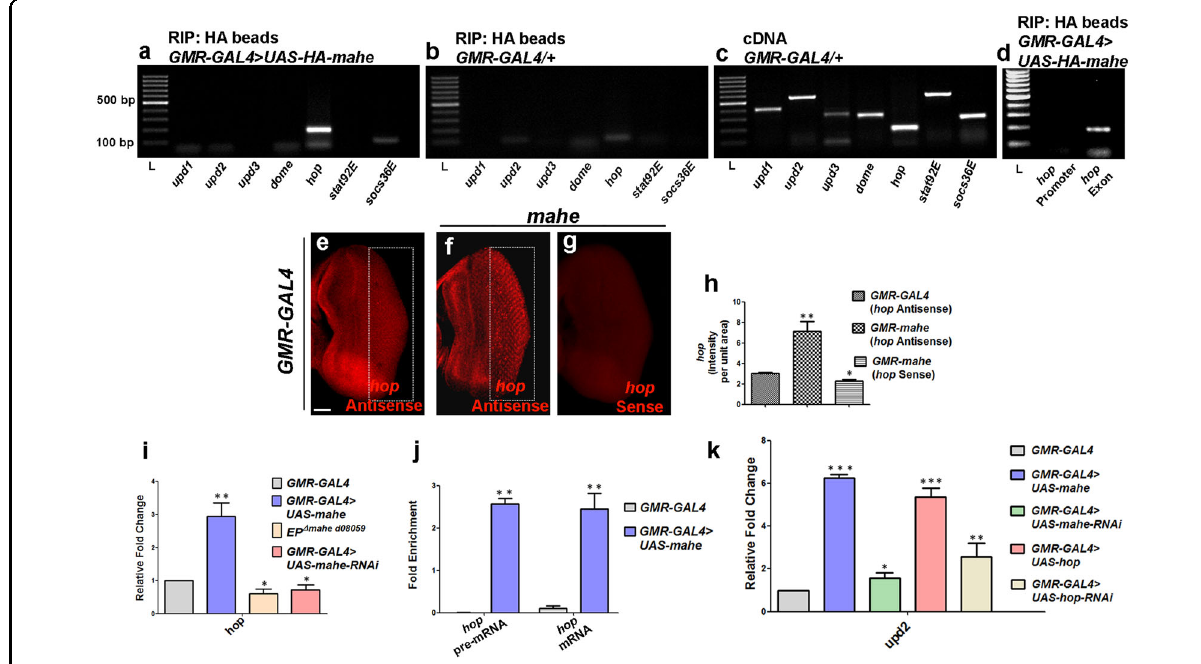
Fig. 4 Mahe directly binds to hop transcripts and increases/stabilizes its level leading to upregulation of upd2 ligand. a , b , d RNA immunoprecipitation was done using Anti-HA beads to immunoprecipitate HA-tagged-Mahe along with associated RNA-protein complex. a Protein lysates from GMR-GAL4 > UAS-HA-mahe was used for immunoprecipitation followed by RT-PCR with primers speci fi c for components of JAK/STAT pathway. Out of the different components upd1 , upd2 , upd3 , dome , hop , stat92E , and socs36E of JAK/STAT signaling, only hop was ampli fi ed